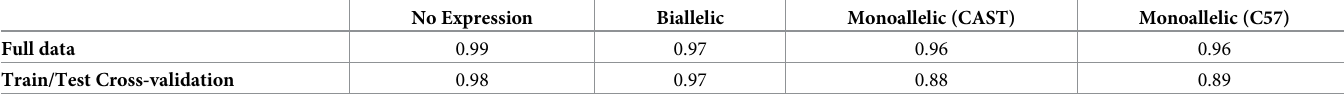
Full data uses all the cells to infer transcriptional burst kinetics compared to all cells. The cross-validation approach randomly splits the cells into two equal groups. One group is used to infer kinetics for prediction and the other group to calculate the observed